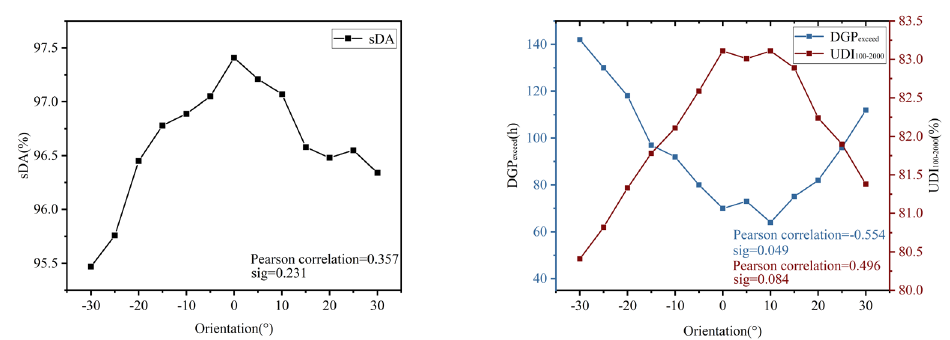
Figure 9. Analysis of building orientation simulation results.